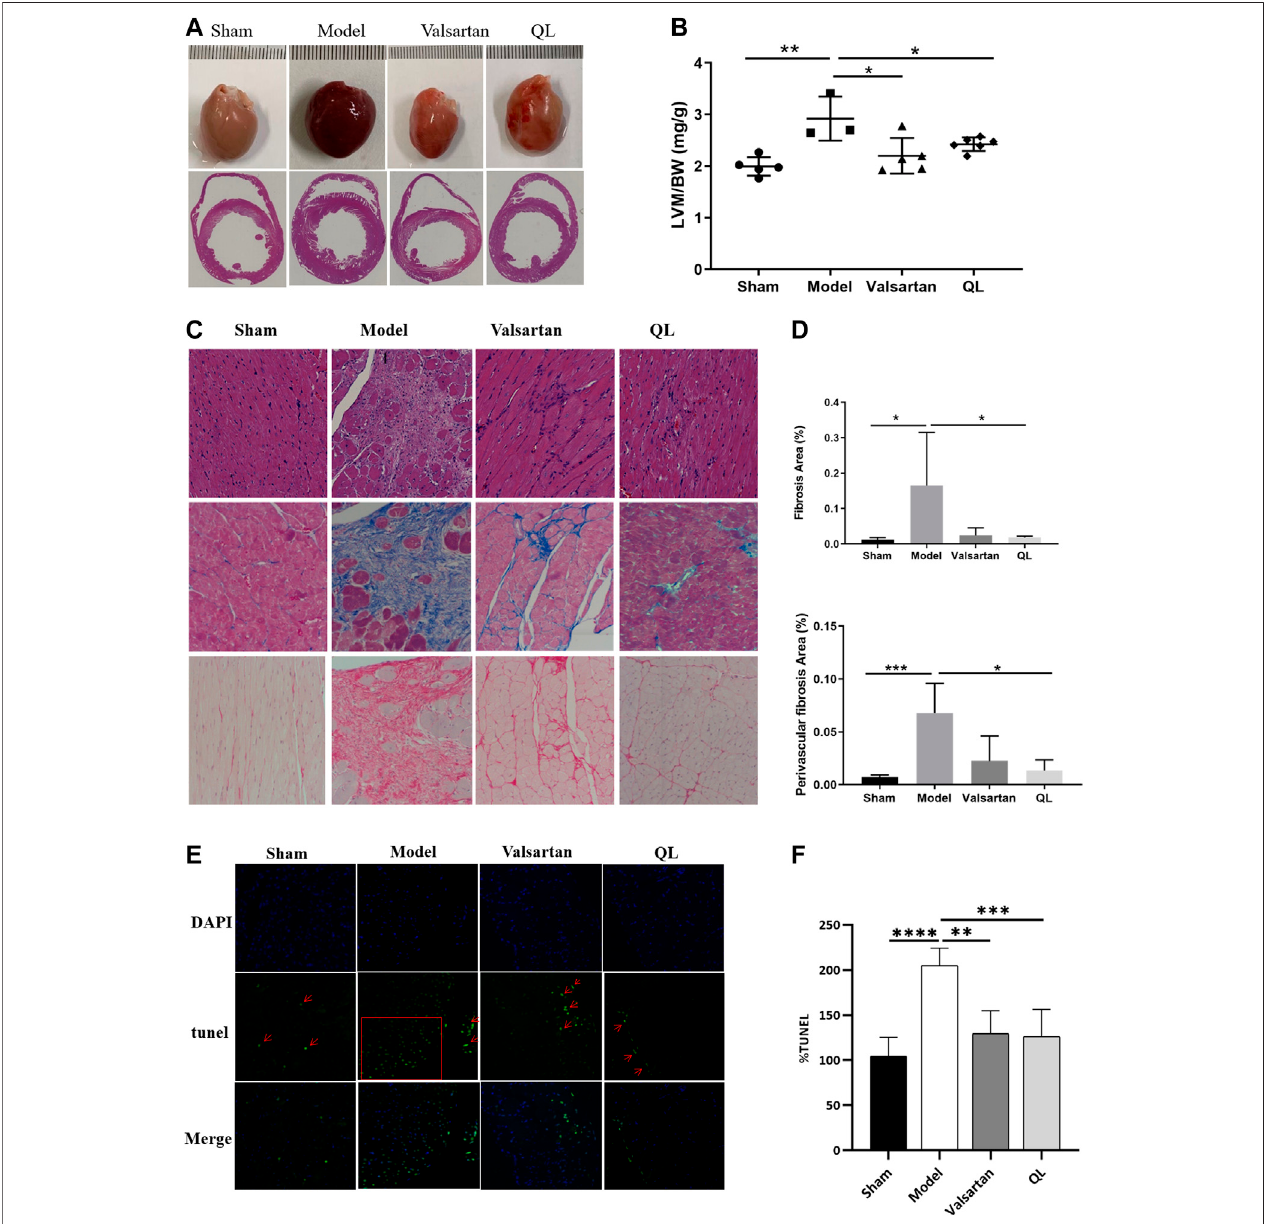
FIGURE2| QLreversedventricularremodeling andalleviatecardiomyocyte apoptosisofratswithHF. (A) Appearanceand transverse sectionoftheheart. (B) Left ventricular mass to total body weight. (C) Histopathologic changes of the cardiac tissue with H&E staining and myocardial fi brosis observed with Masson staining and Sirius Red staining (Scale bar = 100 µm). (D) Quanti fi cation of heart fi brosis area. (E) TUNEL staining for cell apoptosis rate. (F) Relative apoptosis rate of the myocardial cells. The data are the mean ± standard deviation ( (cid:1) x ± s ) (n = 3,4,5, or 6 per group) * p < 0.05, ** p < 0.01, *** p < 0.001, **** p < 0.0001.